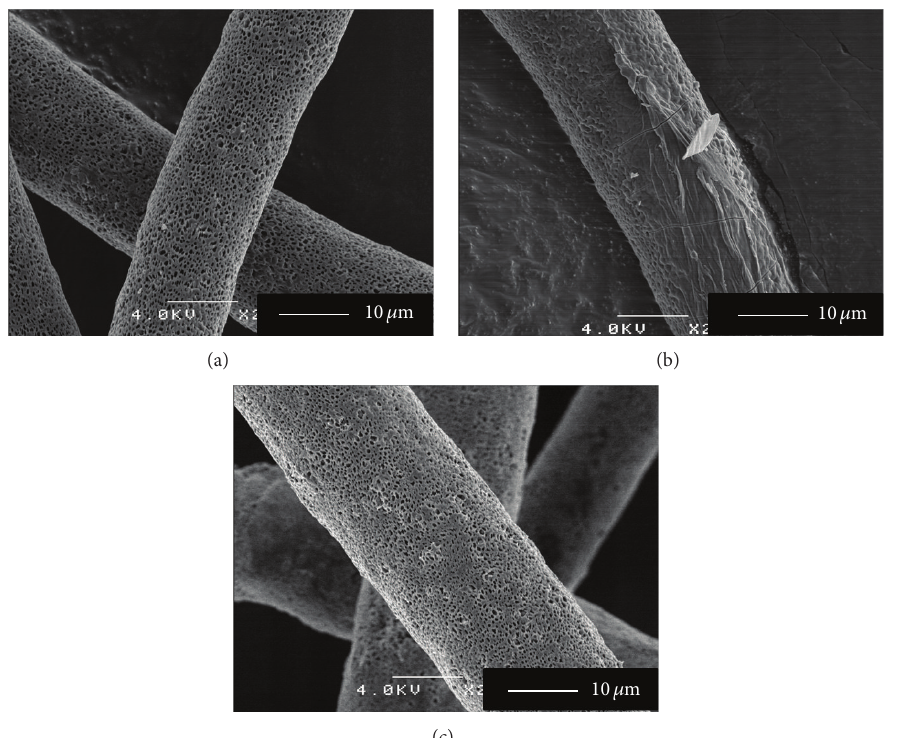
Figure 1: SEM images of (a) PLLA/SiV and ((b), (c)) INT-modified PLLA/SiV; (b) PLLA/SiV-INT(50-1) and (c) PLLA/SiV-INT(10-5).